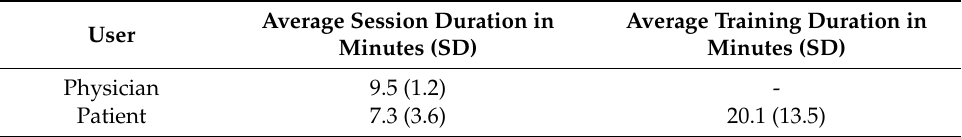
Table 8. Mean and standard deviation of session and training